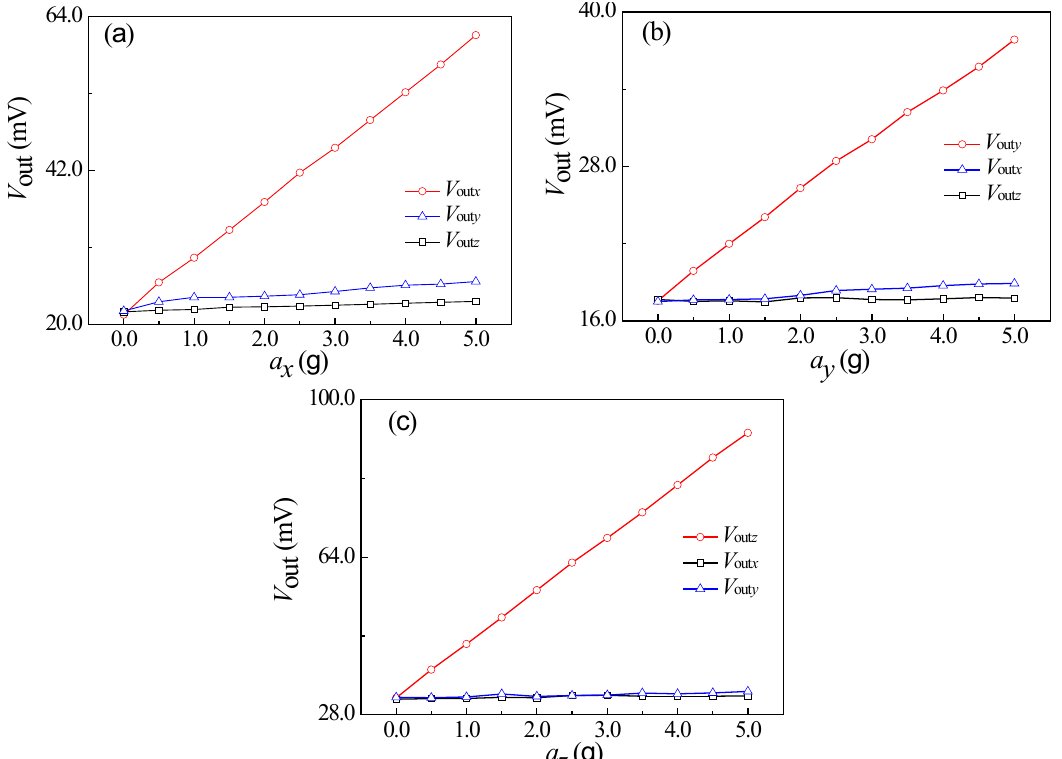
Figure 12. The relationship curves of output voltage and applied acceleration. ( a ) The relationship curves of output voltage and a x . ( b ) The relationship curves of output voltage and a y . ( c ) The relationship curves of output voltage and a z .